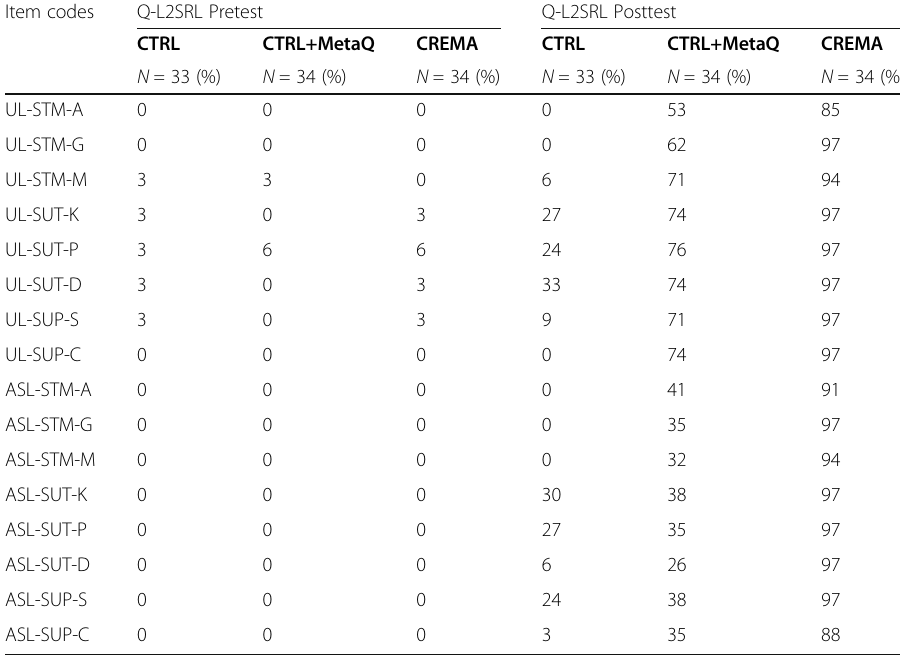
Table 6 Frequencies of students who gained S2SRL in MWP learning for individual items Item